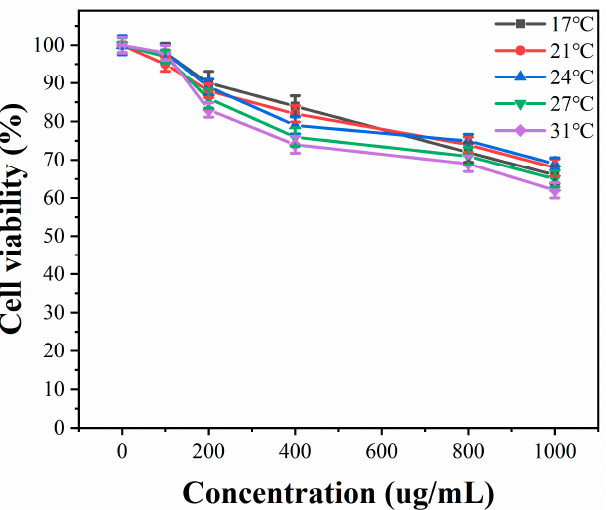
Figure 1. Results of a 24 h cytotoxicity test of crucian carp epiderma mucus on the 8988t human pancreatic cancer cell line at five different temperatures.